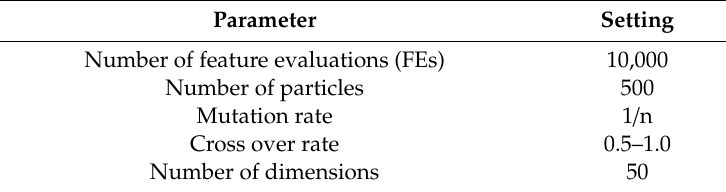
Table 2. Parameter setting for the genetic